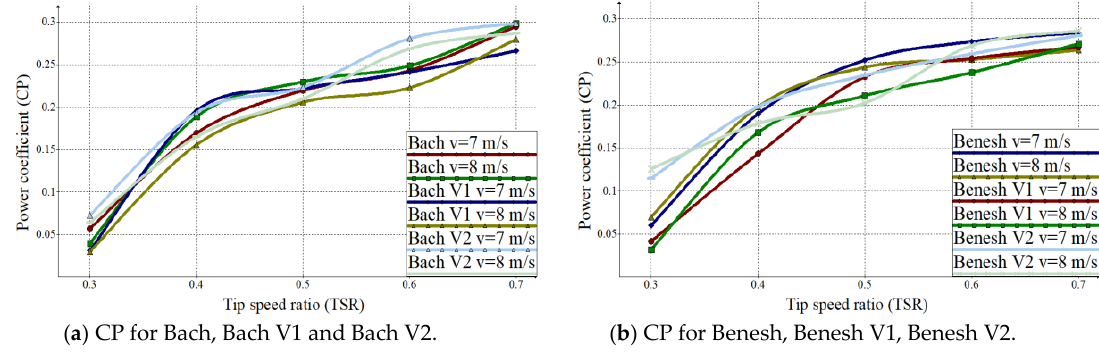
Figure 11. Power coefficient (CP) for analyzed rotor models.